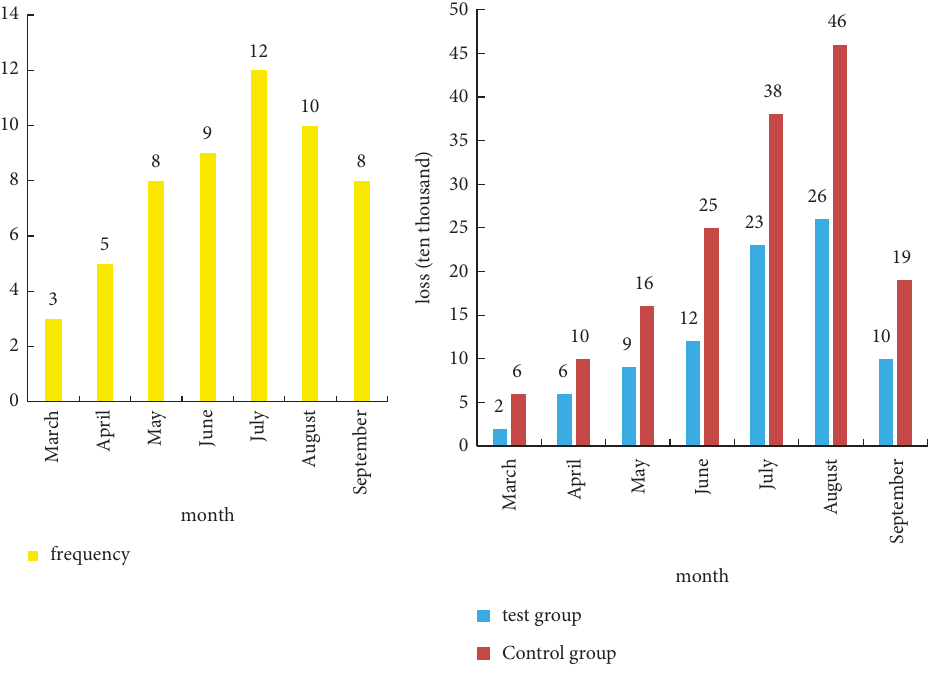
Figure 10: Effect of active